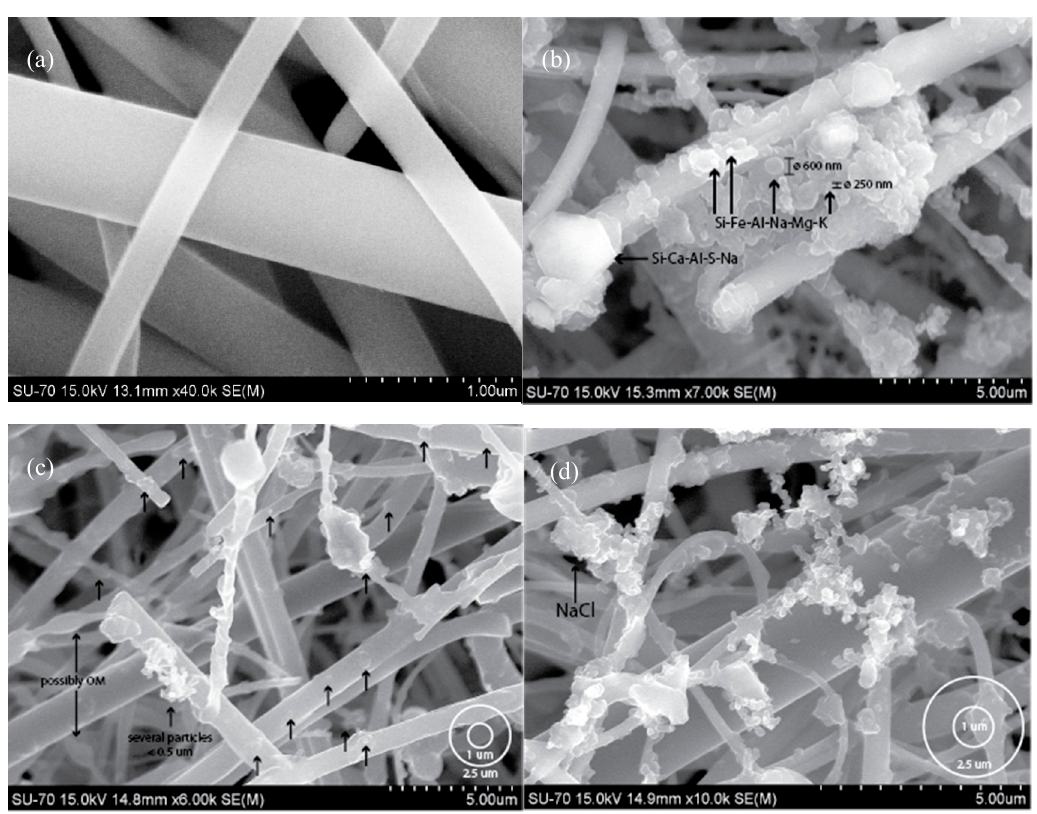
Figure 3. SEM imagens of ( a ) control blank quartz filter with 1.0 µm scale; ( b ), ( c ) and ( d ) collected particles.